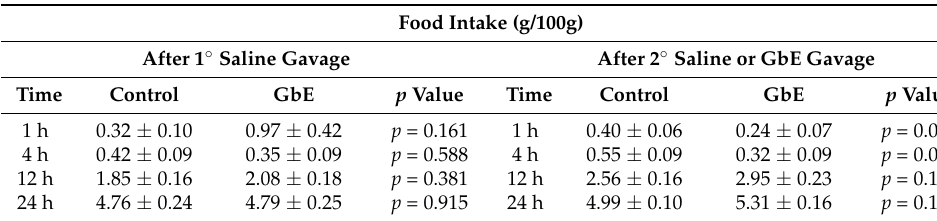
Table 1. Food intake (g/100g). n = 4–6/group.